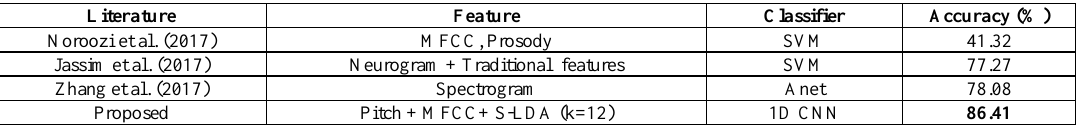
Table 5. Performance comparison of present work with the state of the art methods for eNTERFACE database.